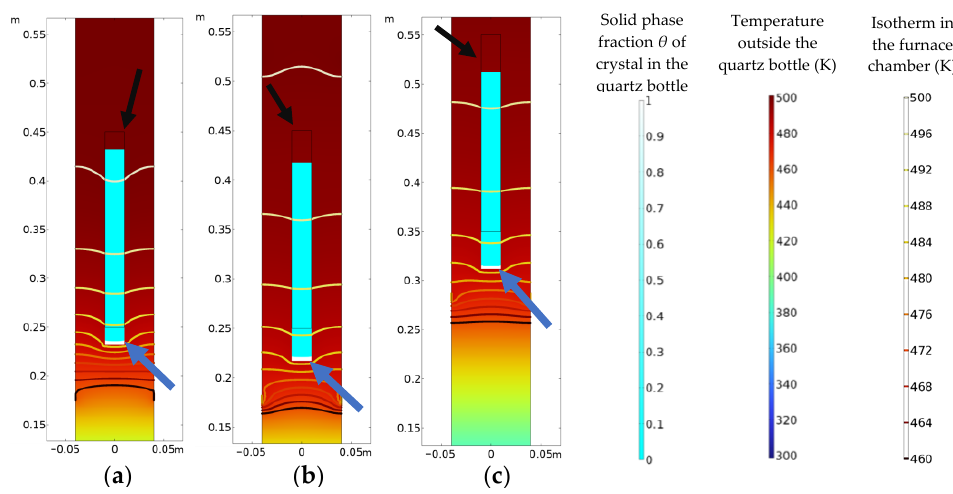
Figure 3. Initial moments of the phase transition: ( a ) process A; ( b ) process B; ( c ) process C.